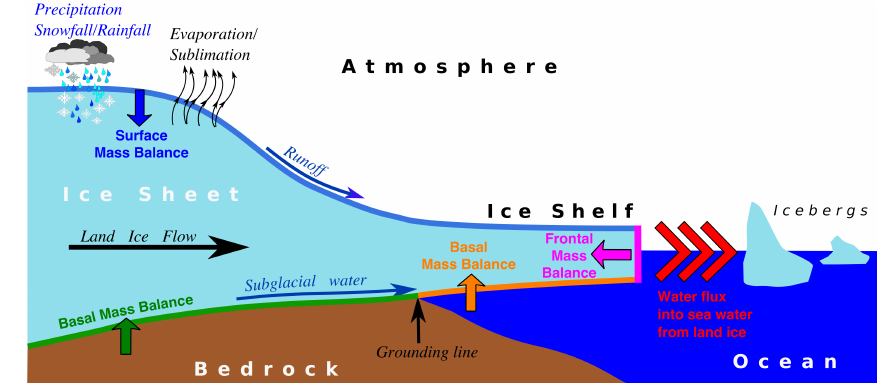
Figure A1. Illustration of the mass change of ice sheets and key processes that are specific to ice-sheet model evaluation or forcing. See text for details.